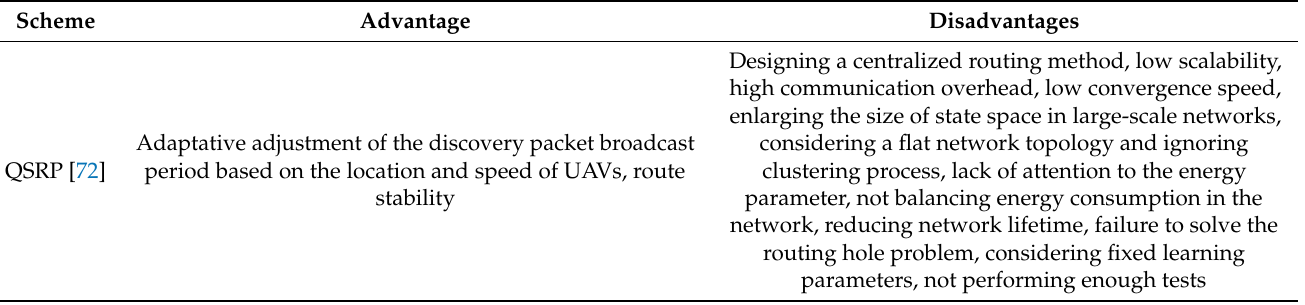
Figure 31. Learning process in QSRP. Table 13. The most important advantages and disadvantages of